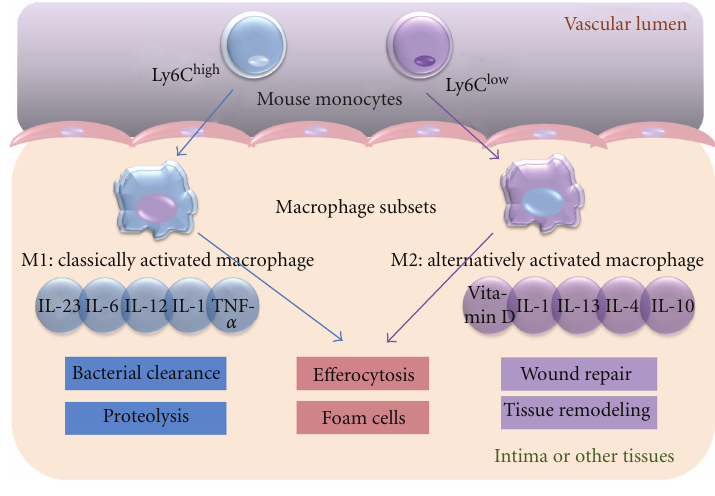
Figure 2: Signalling pathways in a macrophage involved in atherosclerosis. Pro- and anti-inflammatory factors act on macrophages, leading to activation of downstream scavenger receptors (SRs)/toll-like receptors (TLRs)-NF- κ B signalling, endoplasmic reticulum (ER) stress and e ffl ux of cholesterol via ABCA and ABCG